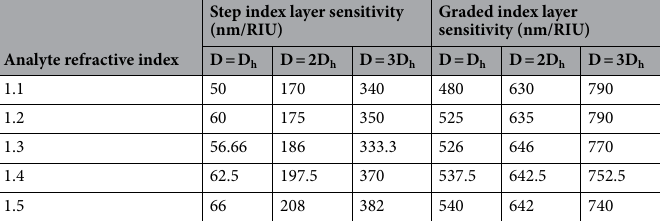
Analyte refractive index